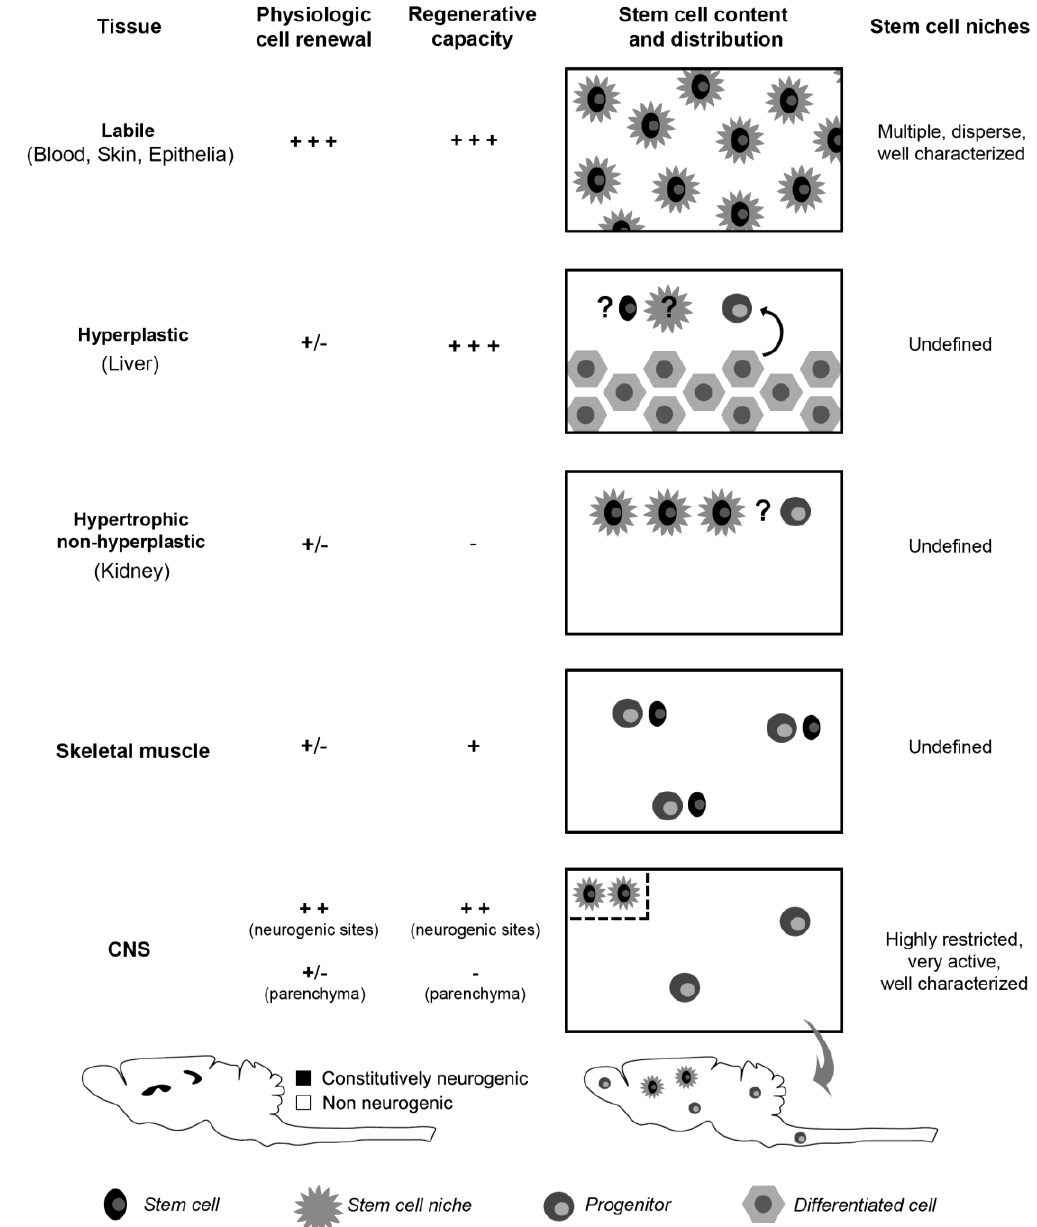
FIGURE 2. Different features of mammalian tissues endowed with different cell turnover and regenerative capacities, with particular reference to their content and distribution of stem/progenitor